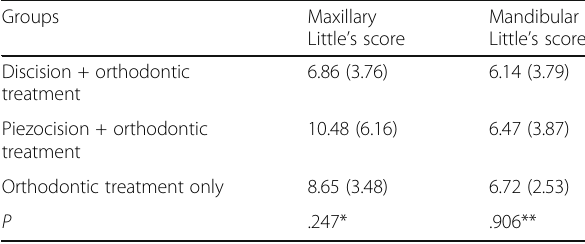
Table 1 Initial Little ’ s irregularity index score of the groups